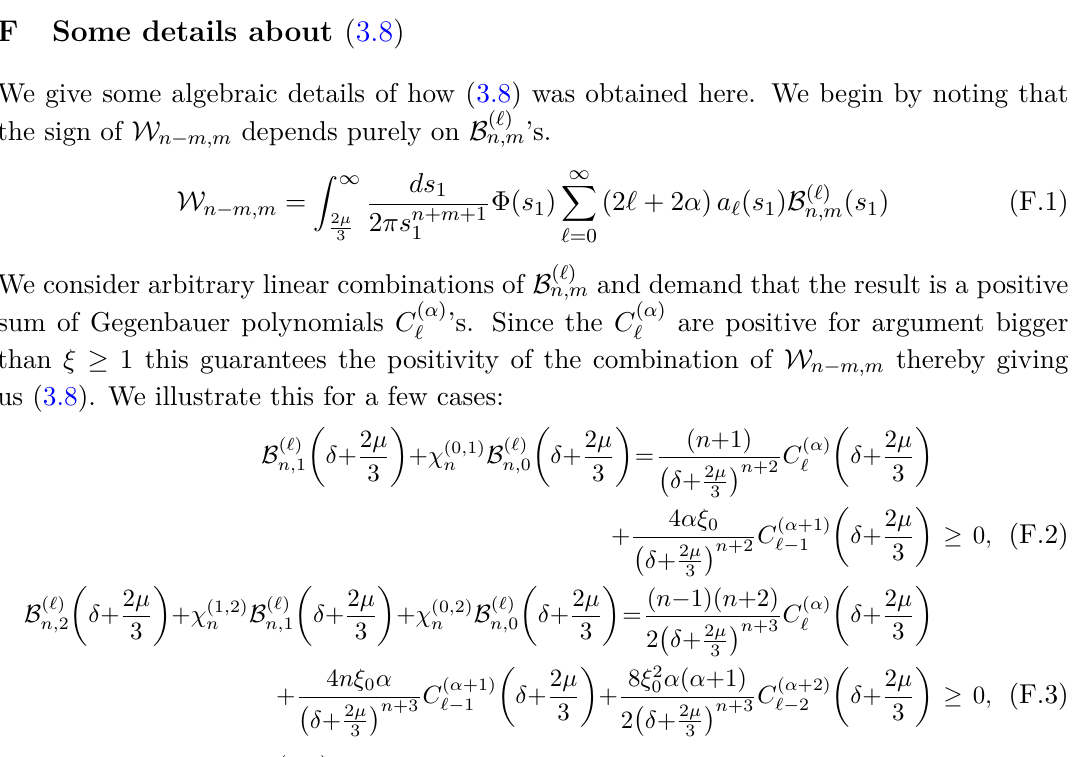
space where there is a 10 % overlap for 1 , s 2 11